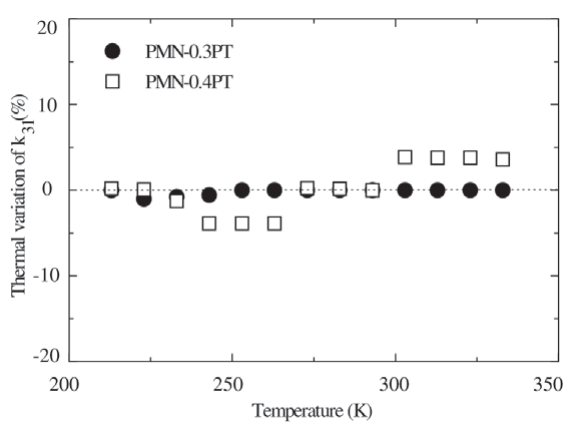
Figure 1. Thermal variation of the coupling factor (k PMN-0.3PT and PMN-0.4PT ceramics.